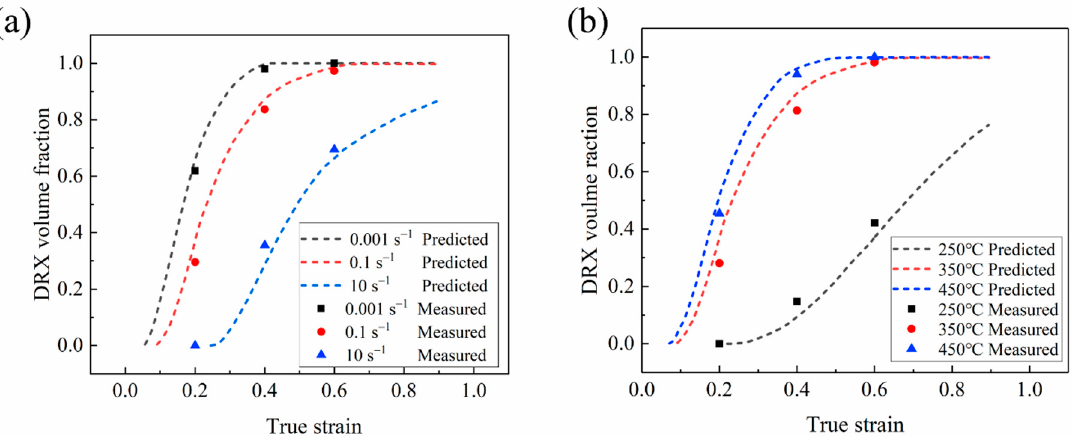
Figure 7. Comparisons between the predicted and measured DRX volume fraction under different deformation conditions of: ( a ) 350 °C and ( b ) 0.1 s − 1 .